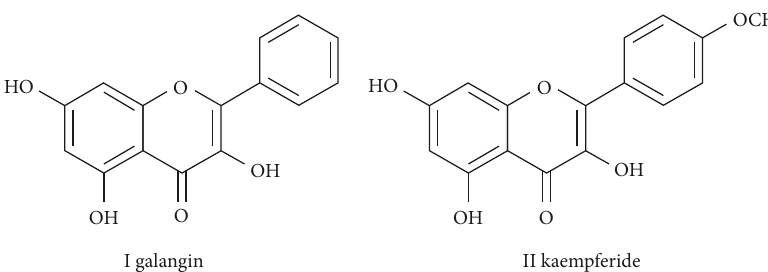
Figure 1: Chemical structures of target-separated antioxidants from A. officinarum